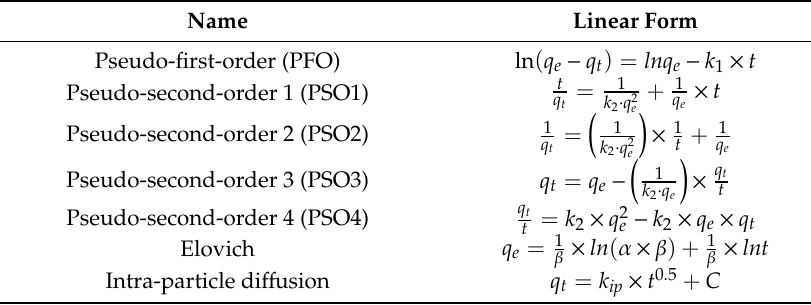
Table 2. The linear forms of kinetic models.